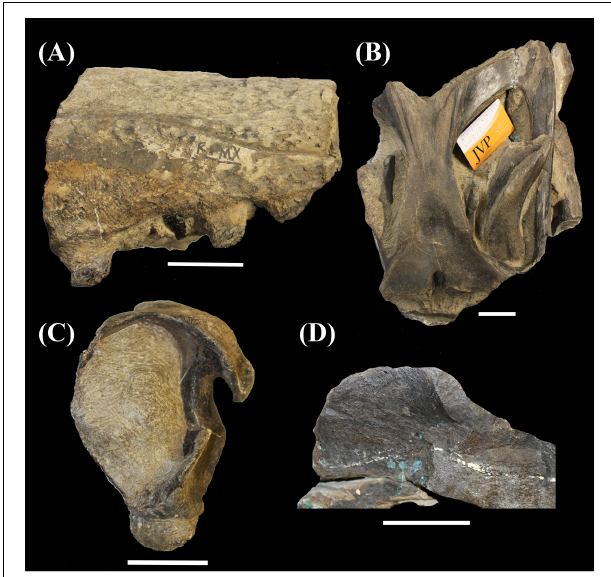
FIGURE 6 | Holotype and only specimen referred to T. neumilleri SDSM 75705, from the Campanian of the Pierre Shale of South Dakota. (A) Fragment of premaxilla and maxilla; (B) parietal table and coronoid; (C) left quadrate; (D) fragment of right articular. All scale bars equal to 100 mm.